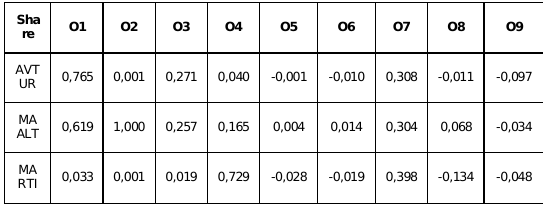
Table 9: Normalized Decision Matrix of Year